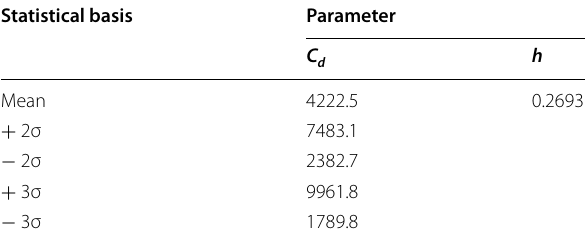
Table 6 Master S–N fitting curve parameters of